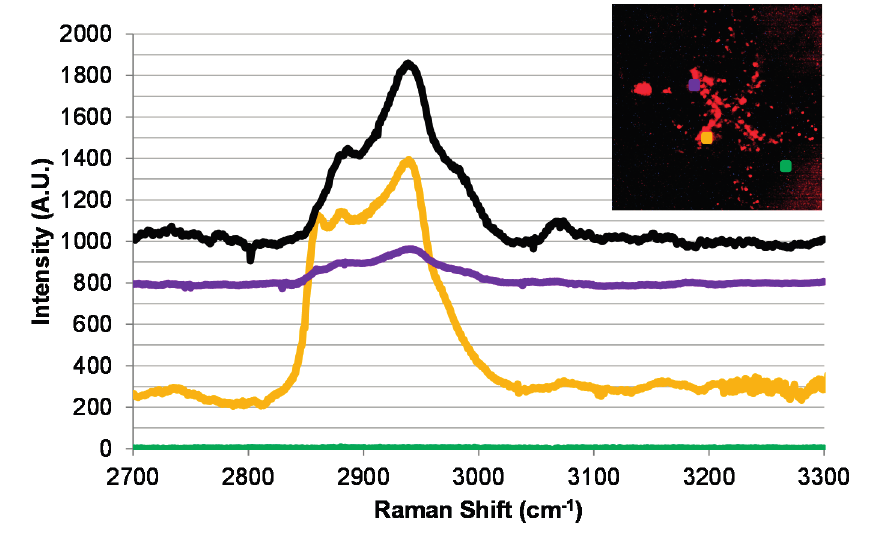
Figure 5. Micro-Raman spectra collected from an anti-fd functionalized microelectrode with captured M13 phages bound to biotinylated-anti-fd reacted with ExtrAvidin-Cy3 prior to photobleaching. The inset in the top right is a magnified image of the collection presented in Figure 4. Black line (positive shifted by 1000 A.U.): a photobleached sample of ExtrAvidin-Cy3 on Silicon. Purple line (positive shifted by 800 A.U.): a scan from the top left point in the inset (indicated by the purple dot). Yellow line (positive shifted by 250 A.U.): a scan from the bottom left point in the inset (indicated by the yellow dot). Green line: a scan from the bottom right point in the inset (indicated by the green